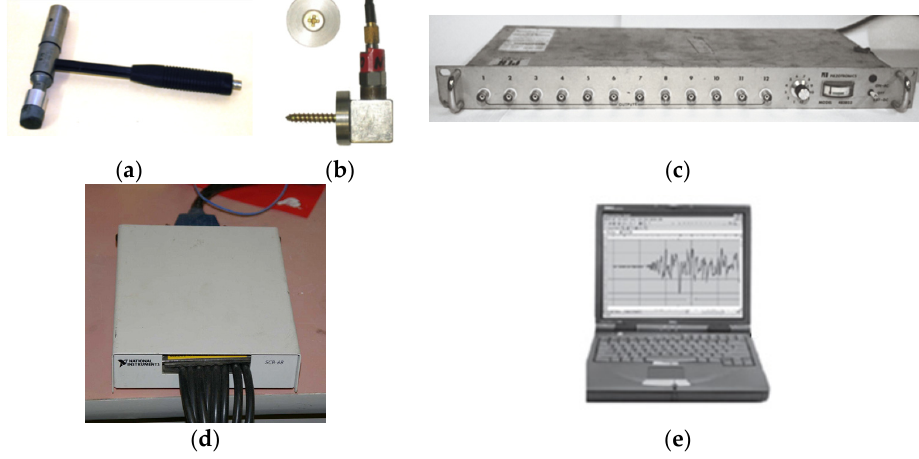
Figure 6. Testing equipment: ( a ) Impact hammer; ( b ) Accelerometers; ( c ) Signal conditioner; ( d ) Data acquisition system; ( e ) Laptop with LabVIEW.